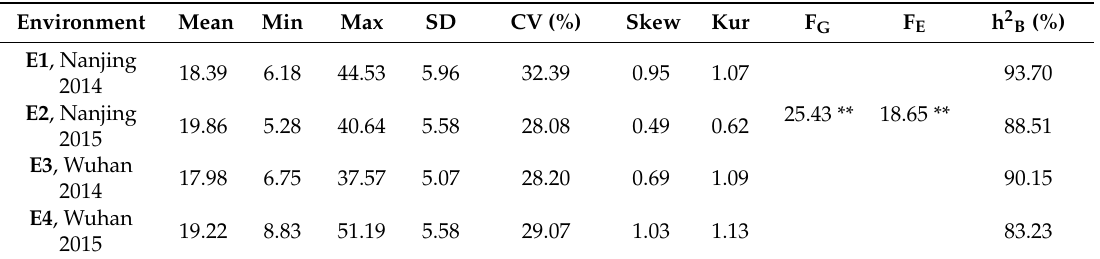
Table 1. Phenotypic analysis of soybean 100-seed weight in 250 accessions in four environments. Environment